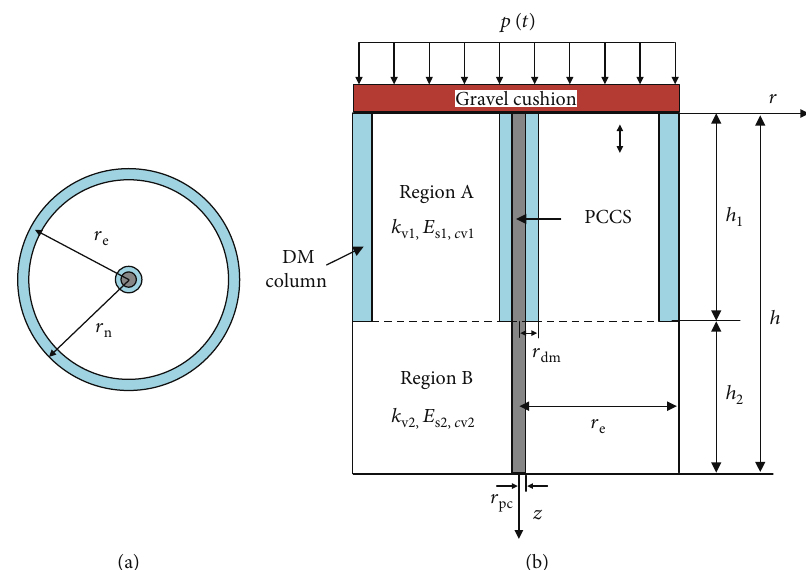
Figure 2: Schematic diagram of consolidation model; (a) plan view; (b) elevation